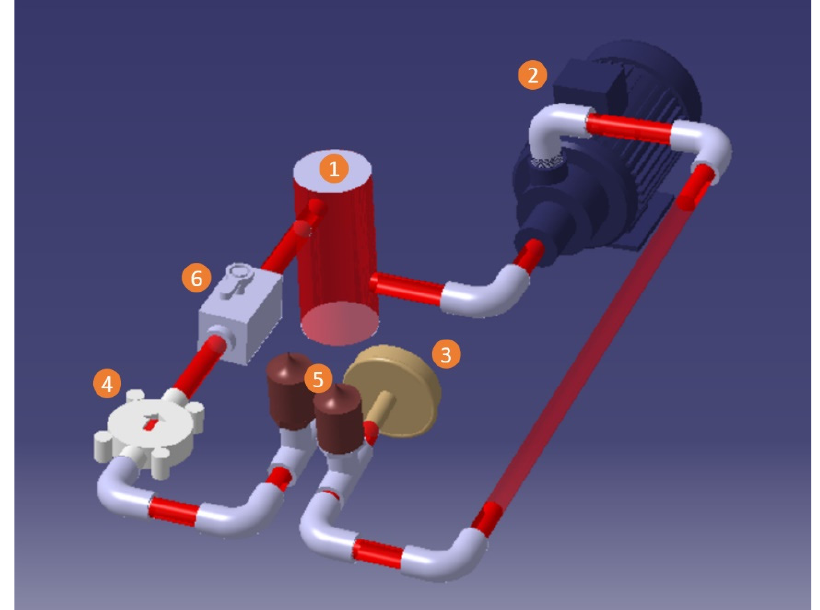
Figure 6. Closed-loop test bench for hydraulic performances: (1) reservoir; (2) circulation pump; (3) prototype-mini pump; (4) flow meters; (5) pressure sensors; (6) valves.